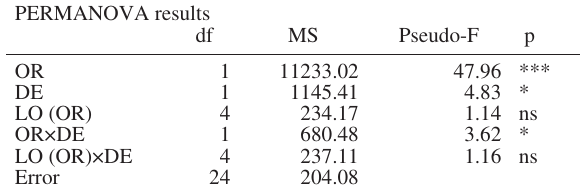
Fig. 4. – PCO diagram based on Bray-Curtis dissimilarities showing sample distribution in relation to the interaction between coastal orienta- tion (triangles: N; circles : NW) and depth (white, 3 m; black, 7 m). Variables were fourth-root transformed and the vector overlay (Spearman rank correlation >0.5) indicates the relationship between taxa and PCO axes. Table 3. – Summary of PERMANOVA results testing for the ef- fect of coastal orientation (OR), location (LO) and depth (DE) on the composition and abundance (biomass ratios) of the epiphytic taxa growing on G. corneum (ns=non significant, *<0.05, **<0.01, ***<0.001). Pairwise comparisons for the OR×DE interaction are